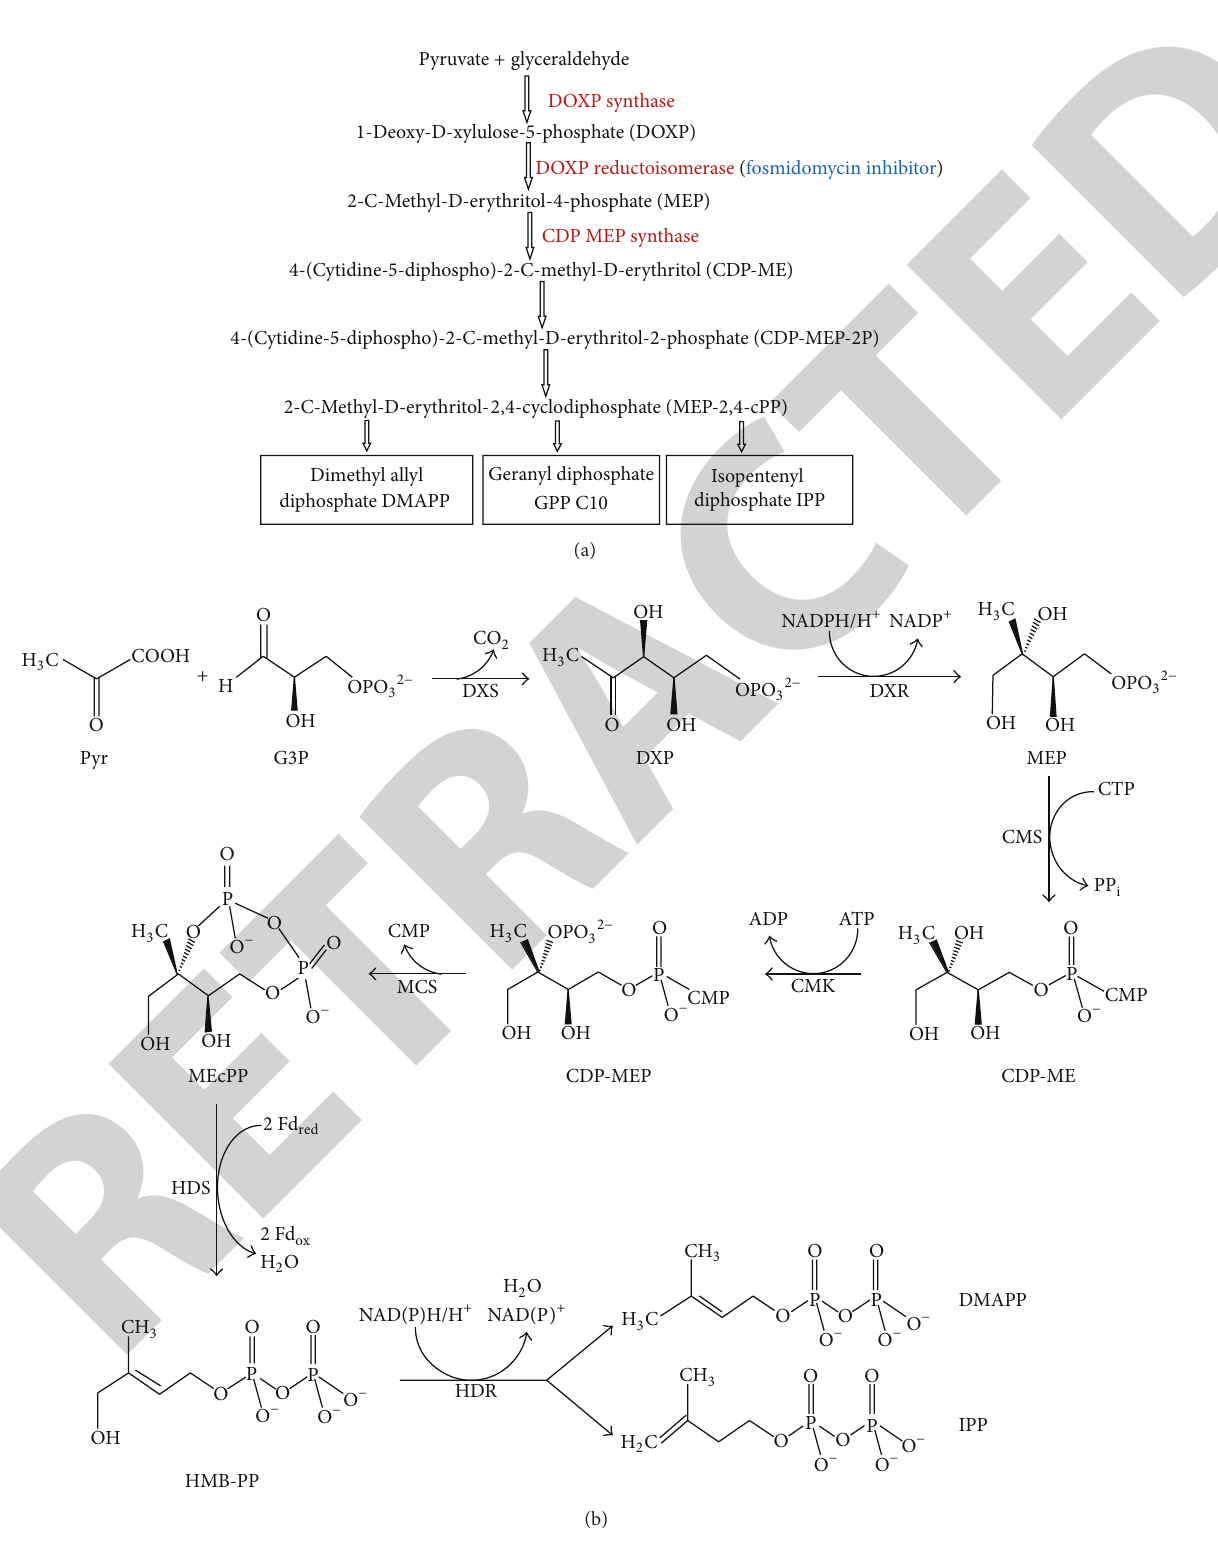
Figure 2: (a) Synthesis of isoprenoid compound by nonmevalonate pathway: a flow chart; (b) chemical reactions involved in biosynthesis of isoprenoid via nonmevalonate